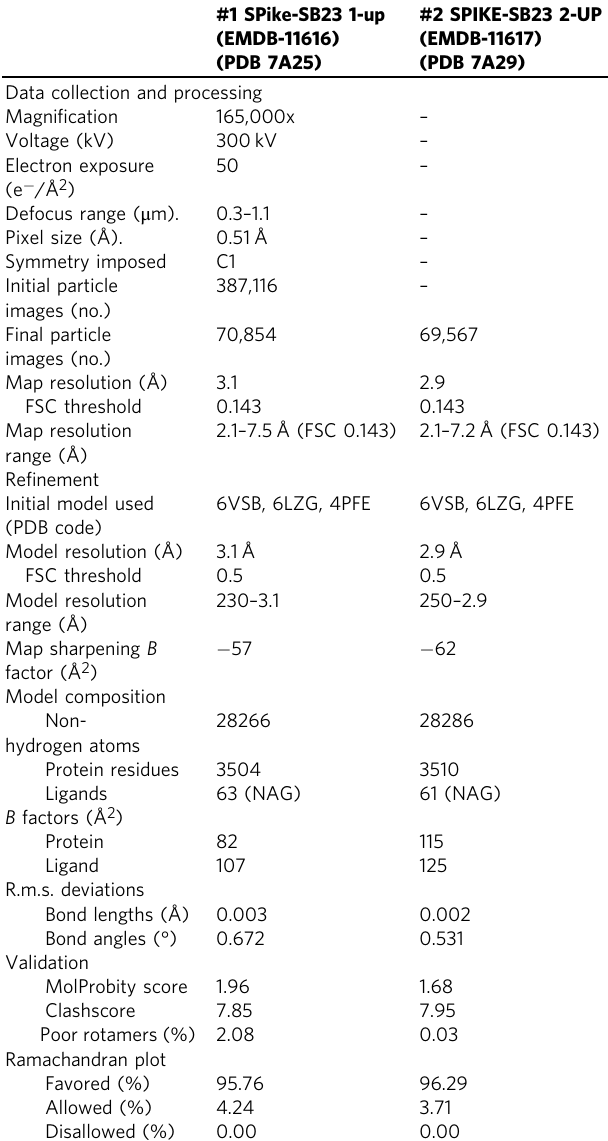
Table 2 Cryo-EM data collection, re fi nement, and validation